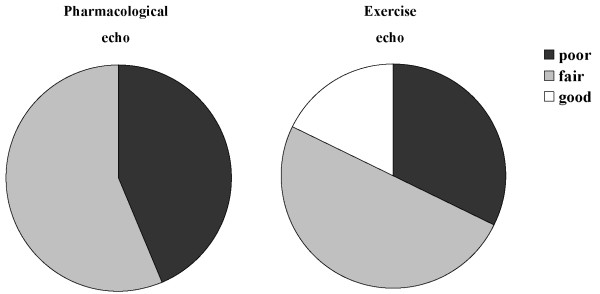
Distribution of patients according to RT3D image quality separating the study group into pharmacological and exercise stress echo.